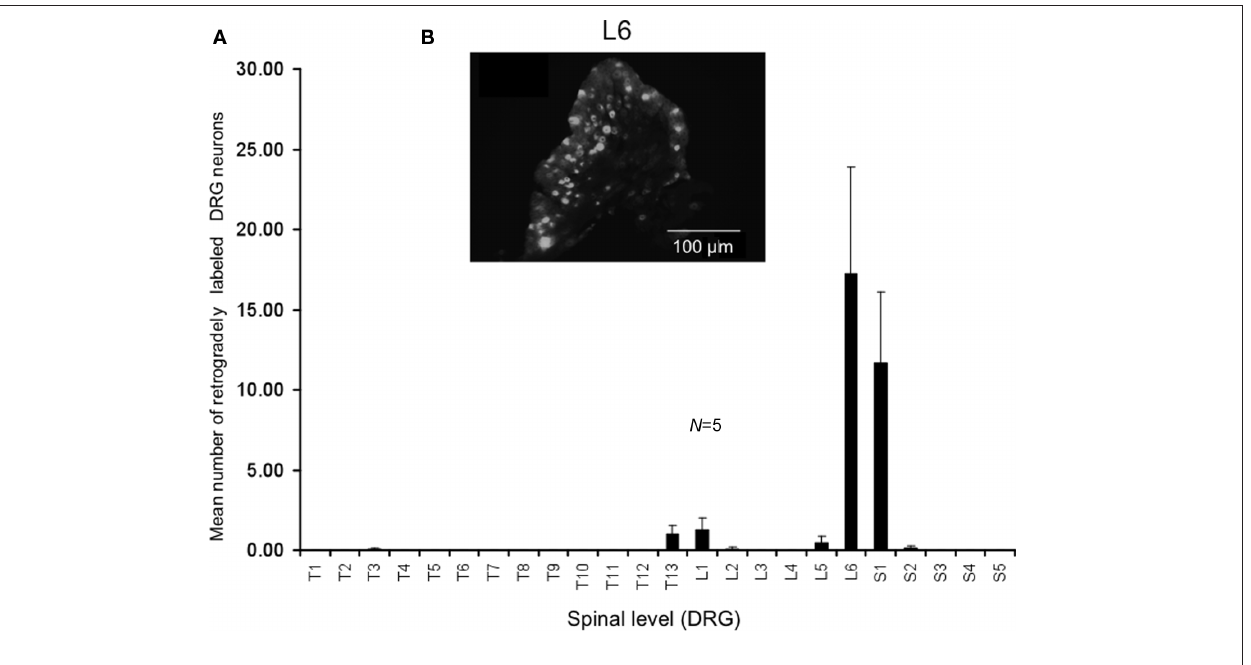
neurons were identified. The majority of labeled neurons were identified in the lumbosacral region of spinal cord. Primary labeling was identified at levels of L6 and S1. (B) Fluorescence micrograph showing labeled neurons at